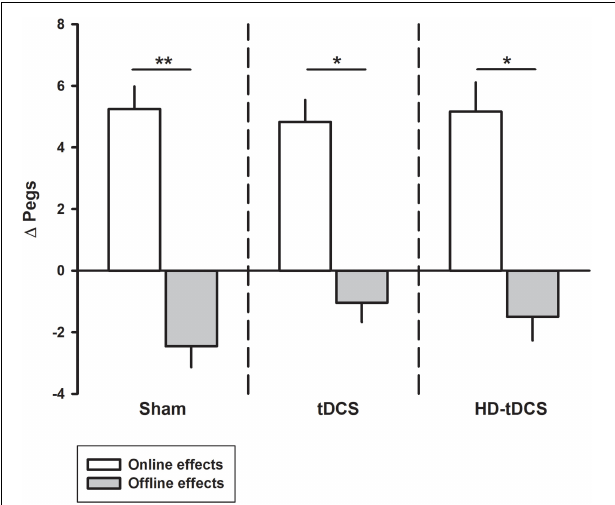
FIGURE 3 | Online and offline learning effects on left hand Purdue Pegboard (PPT L ) for the three intervention groups. The online effects represent the difference in PPT L score from the first and last training point of the day. The offline learning represents the difference between the last training time point of the day to the first training point of the following day. ∗ p < 0.05, ∗∗ p < 0.01.